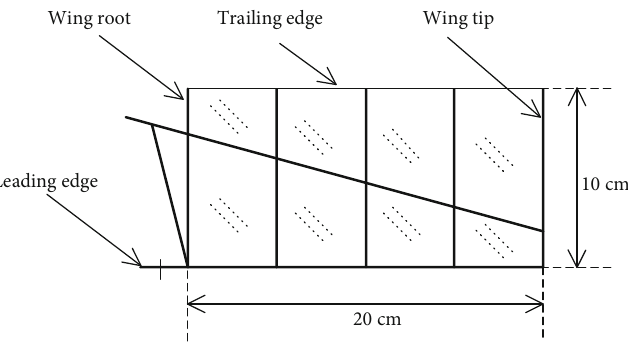
Figure 5: Schematic of the designed fl apping-wing